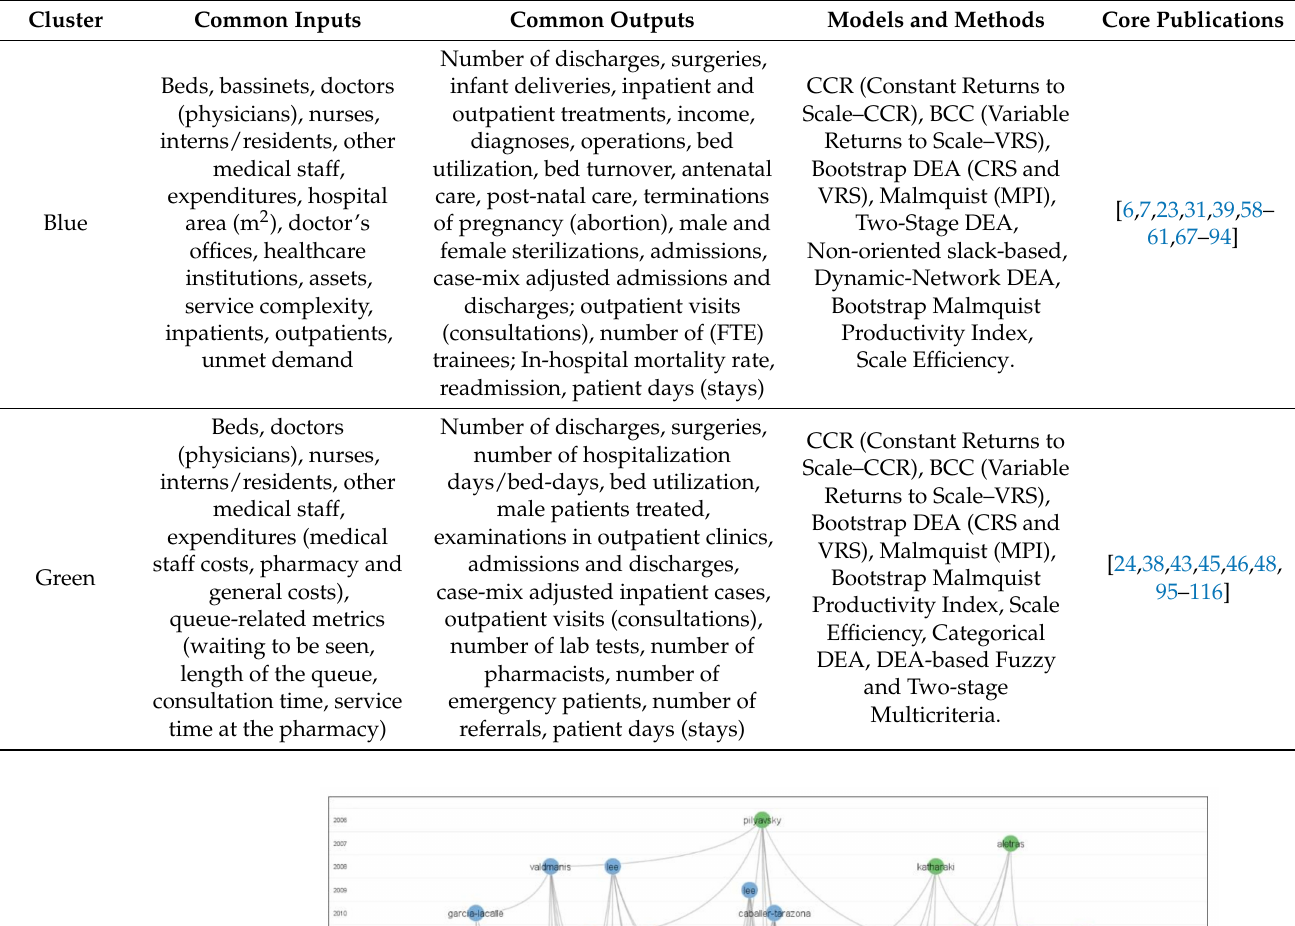
Table 2. Core-publications clusters, variables and models.